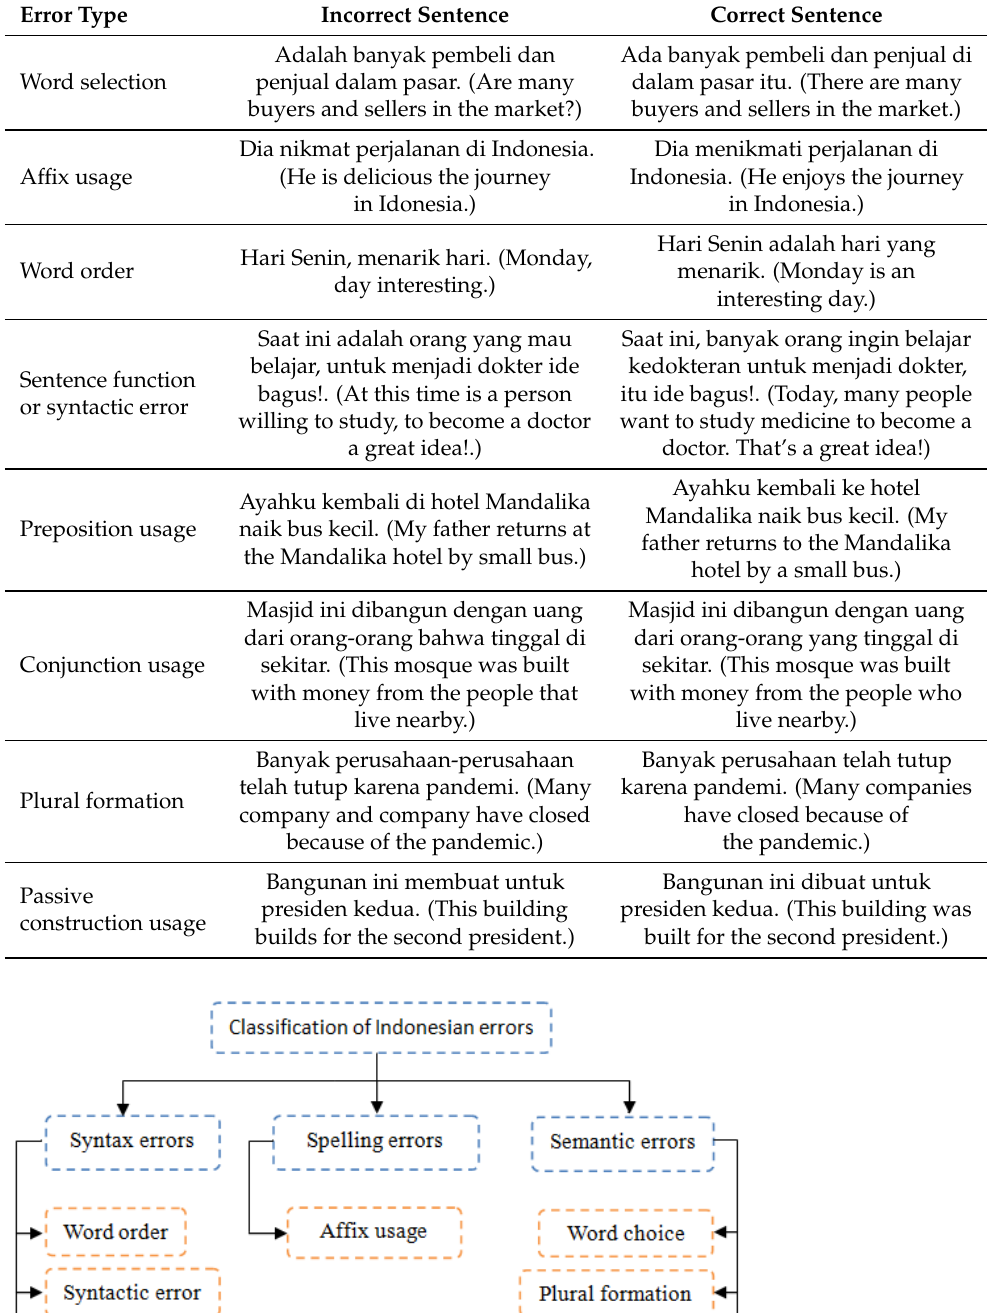
Table 1. Types of Indonesian grammatical errors.